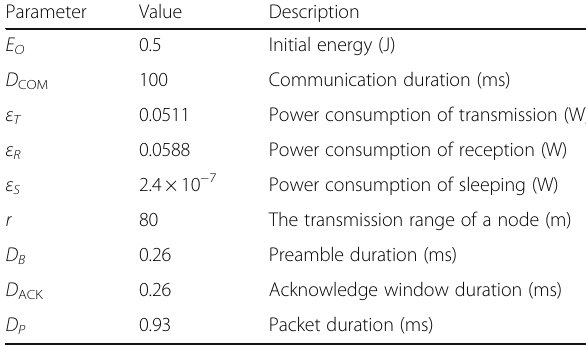
Table 2 Simulation parameters